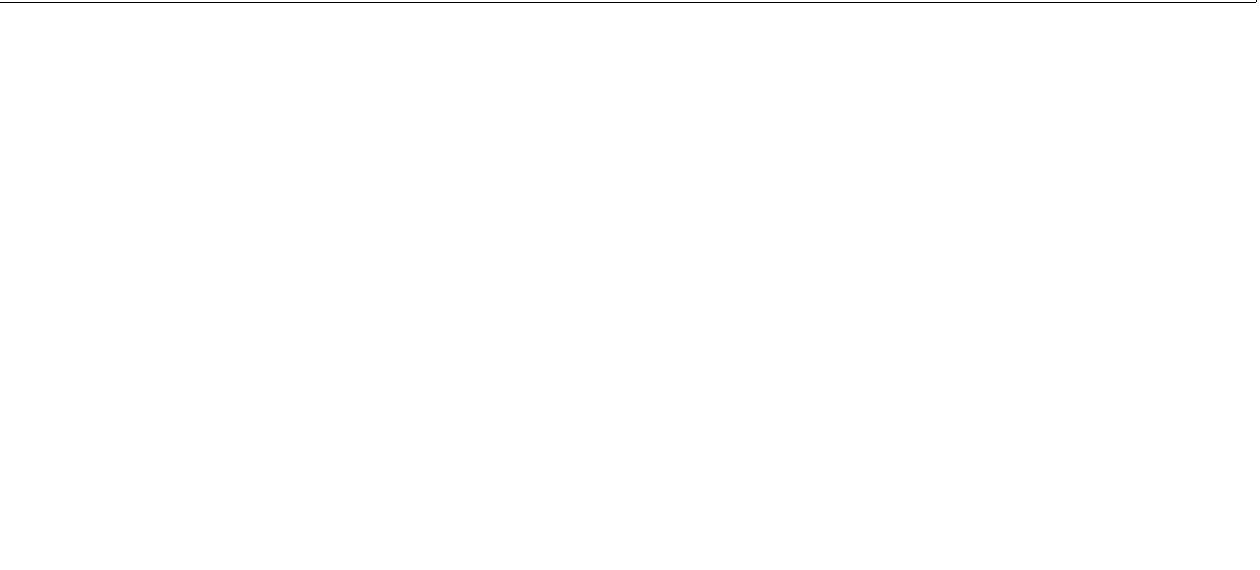
FIGUREA3 | Hydropathy profiles (A) and amino acid alignment (B) of zebrafish CA2a and CA15a. (A) Kyte–Doolittle hydropathy plots generated by using a window size of 9 (Kyte and Doolittle, 1982). Gray bar represents a putative signal peptide and green bar, a hydrophobic